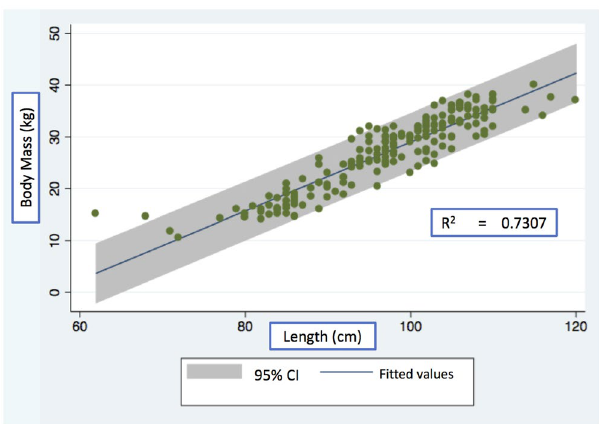
Figure 1. Linear regression model scatter plot with corresponding 95% confidence interval.